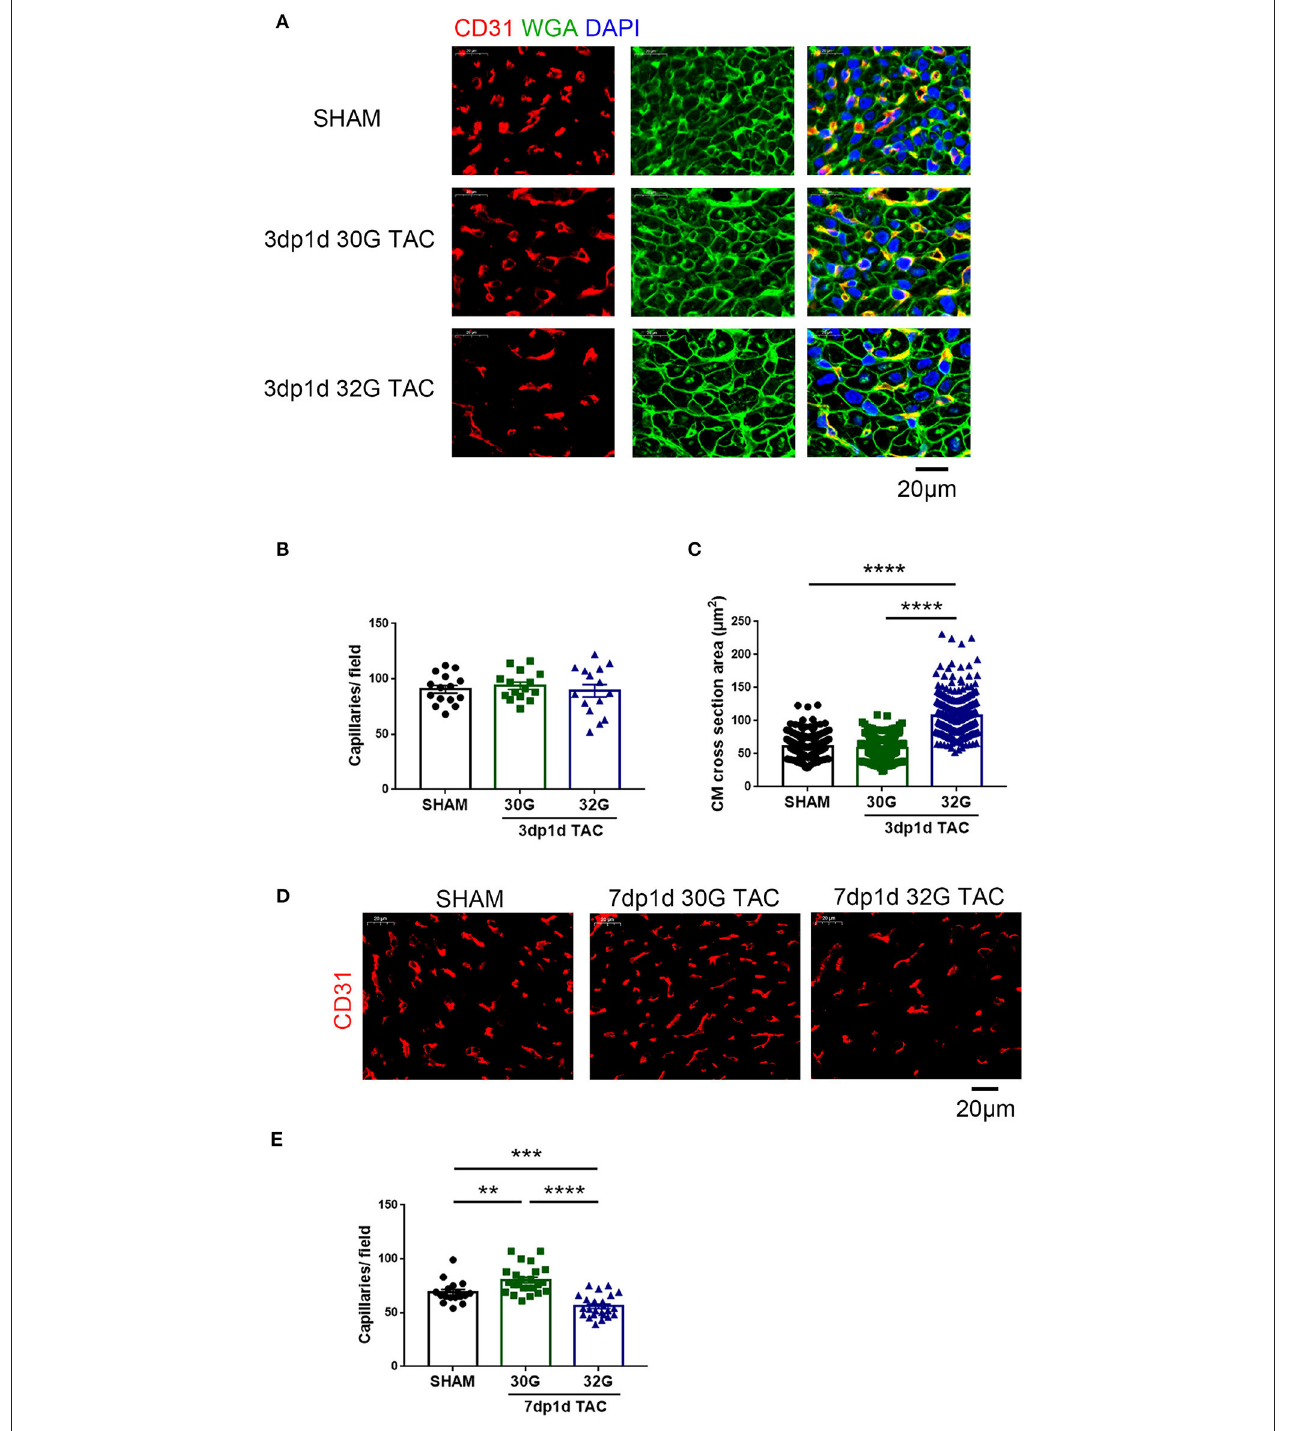
FIGURE 4 | The effect of different constrictions on myocardial hypertrophy and angiogenesis. (A) Immunostaining for CD31 (red), wheat germ agglutinin (WGA, green), and DAPI in heart sections. Scale bar: 20 µ m. (B) Quantification of CD31 + capillaries/field; n = 3 hearts per group. Each heart slide was random selected with five high-power fields for statistical analysis. (C) Analysis of cardiomyocyte cross-sectional area in the three groups; n = 3 hearts per group. A total of 300 cardiomyocytes per group were analyzed. (D,E) Immunostaining of heart slides for CD31 and quantification of capillary density. Scale bar: 20 µ m; n = 3 hearts per group. Each heart slide was random selected with five to eight high-power fields for statistical analysis. Data are presented as mean ± SEM. ** P < 0.01, *** P < 0.001, and **** P < 0.0001. Statistical significance was calculated using the unpaired two-tailed t -test.